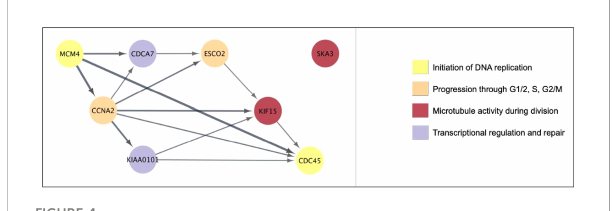
FIGURE 4 The eight genes that are both highly overexpressed during acute HIV and correlated with viral load have core cell cycle functions. Generated using Cytoscape. Nodes were colored according to broad function as per the legend. Edges represent known protein- protein interactions in the STRING database, with the arrow indicating direction of interaction (source to target), and the weight indicating con fi dence of association (minimum